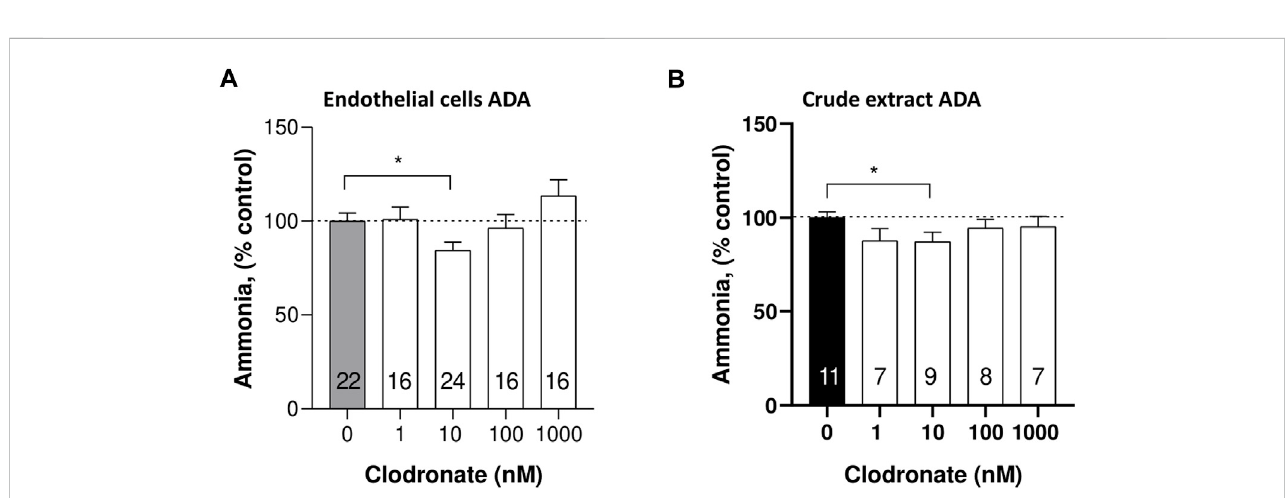
FIGURE 5 Comparison of ADA activity inhibition by 10 nM clodronate in mesentery endothelial cells or a crude calf intestinal enzyme preparation. To assess whether clodronate interferes with ADA activity, mesentery cells (A) or a crude calf intestine extract (B) was used to examine putative enzyme inhibition elicited by clodronate. ADA activity was determined via a colorimetric titration of the ammonia generated as a byproduct of enzyme reaction. Columns indicate the mean values and bars the S.E.M. of multiple enzyme assays performed in the absence or presence of 1 – 1,000 nM clodronate. Numbers insidethecolumnsrefertotheseparatemesenterycellwellsassaysorcrudeenzymeactivityassay.Resultsareexpressedas%ammoniaformedcomparedto parallel controls without clodronate. *, p < .05 unpaired t-test, compared with control, without clodronate.